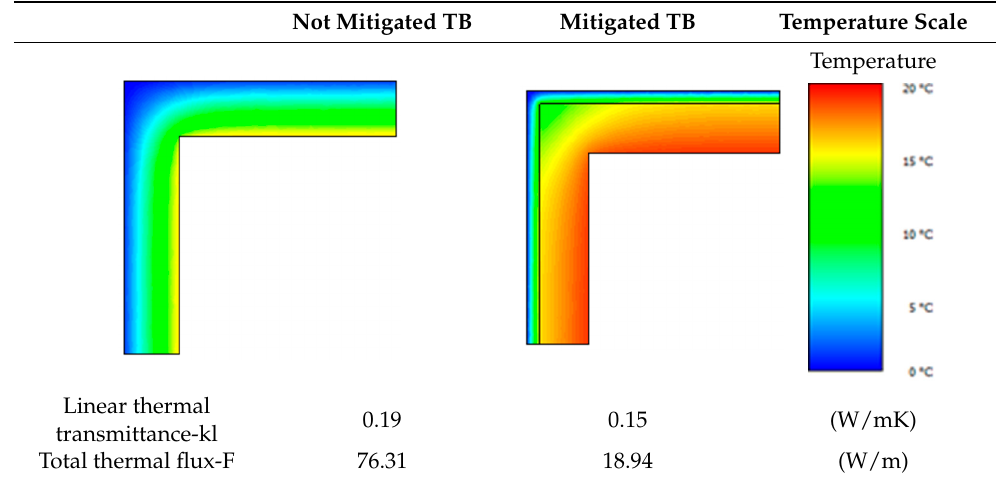
Table 15. C m Thermal bridges.